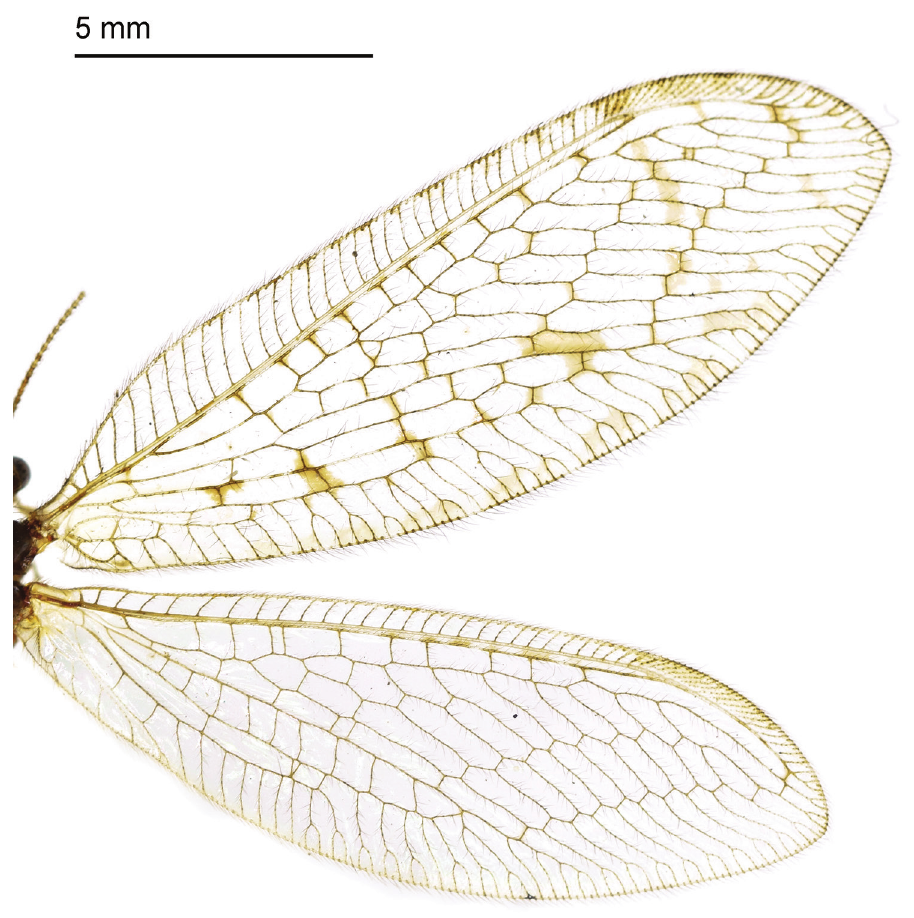
Figure 14. Wings of Heterosmylus limulus Yang,